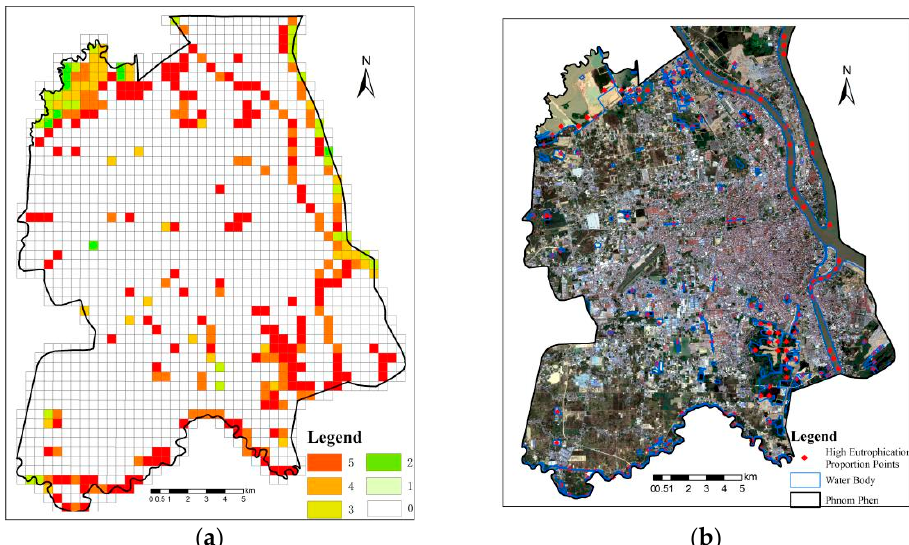
Figure 9. ( a ) Reclassified eutrophication occurrence frequency map; ( b ) High eutrophication fre- quency